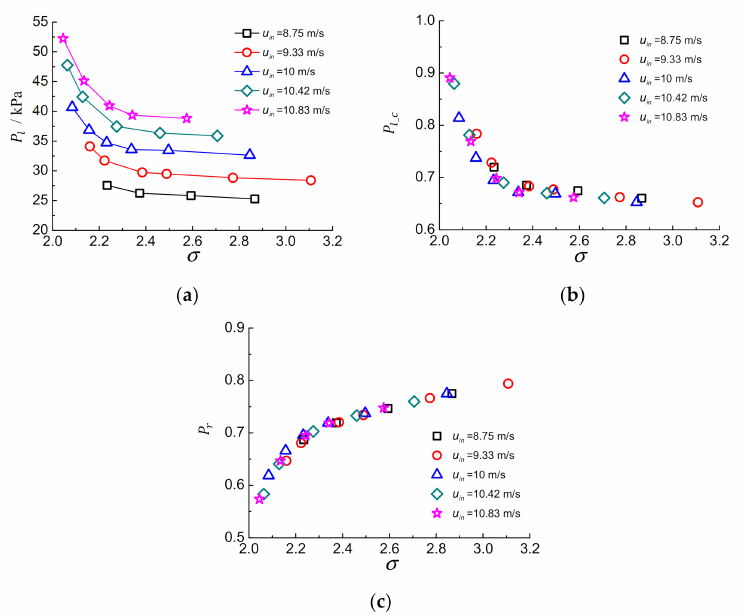
Figure 7. The pressure loss as a function of the cavitation number σ : ( a ) absolute pressure loss, P l ; ( b ) pressure loss coe ffi cient P l _ c and ( c ) outlet-to-inlet pressure ratio P r